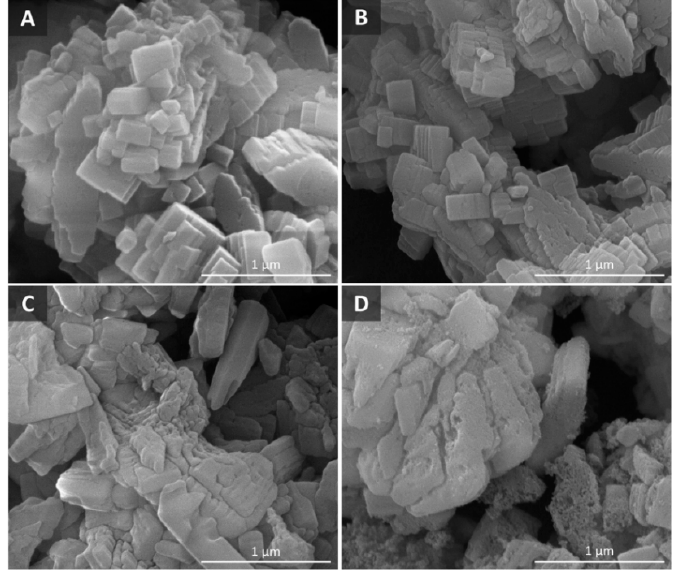
Figure 7. SEM images of ( A ) untreated ZSM-5, and NaOH-treated ZSM-5 at ( B ) 0.2 M, ( C ) 0.5 M, and ( D ) 1 M. (Adapted from Ref. [127]. Copyright 2017 Elsevier).